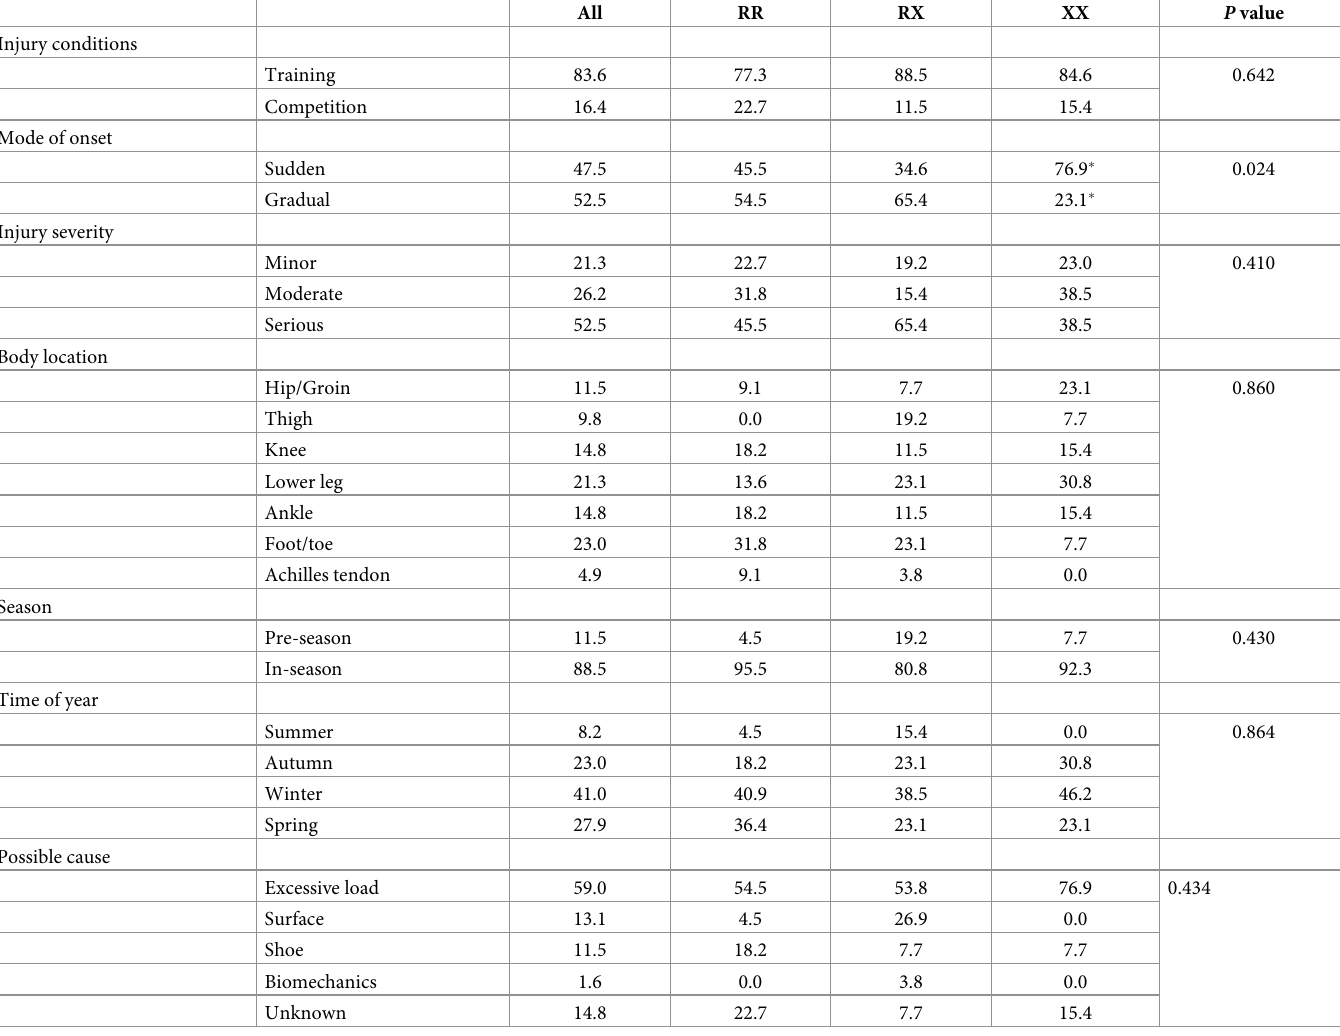
Table 2. Conditions of injury for ACTN3 RR, RX and XX marathon runners. Data are frequencies in percentage for each